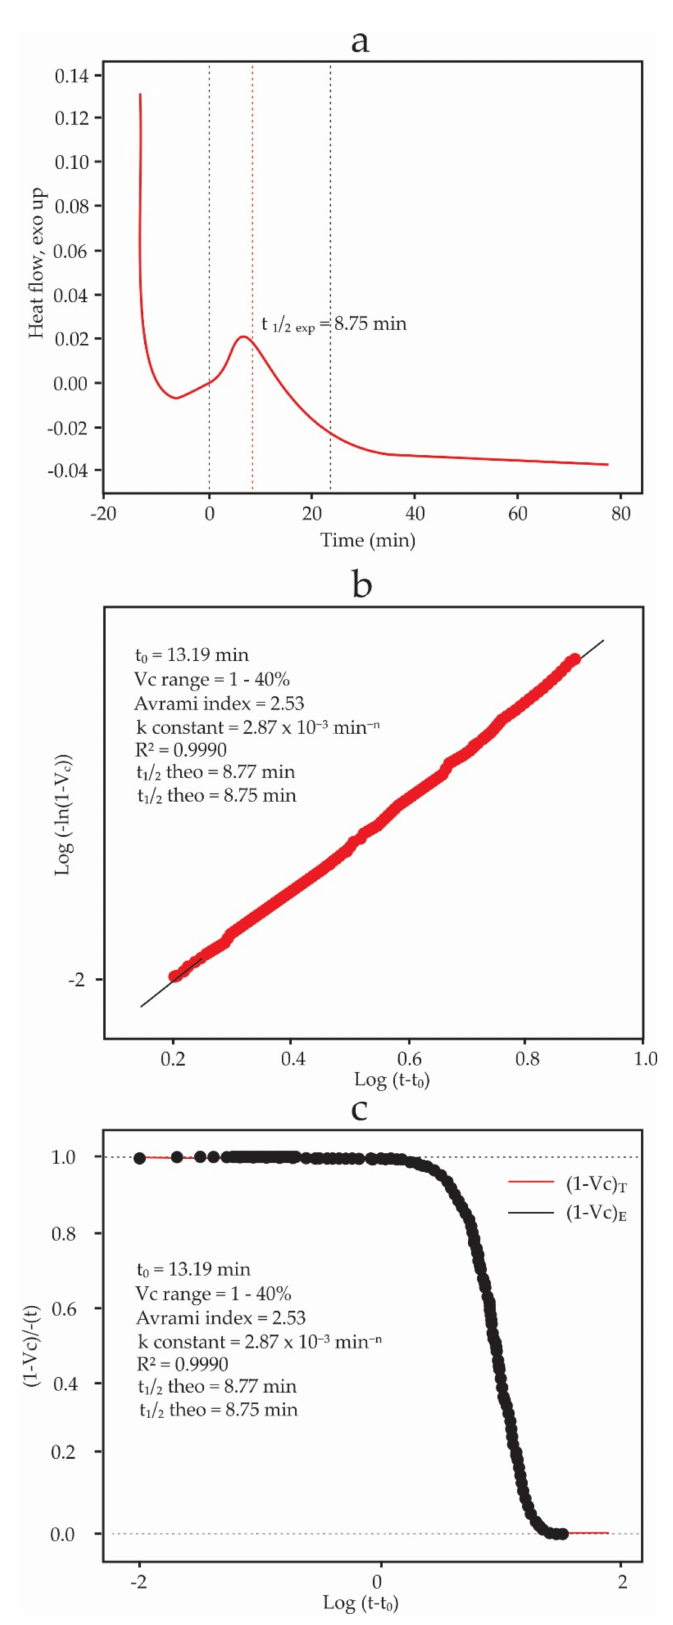
Figure 2. Results of fitting the CB isothermal crystallization data at 15 ◦ C using the package Crystal- lization fit from Origin Pro. ( a ) Exothermal crystallization peak, ( b ) Avrami fitted range, ( c ) relative amorphous